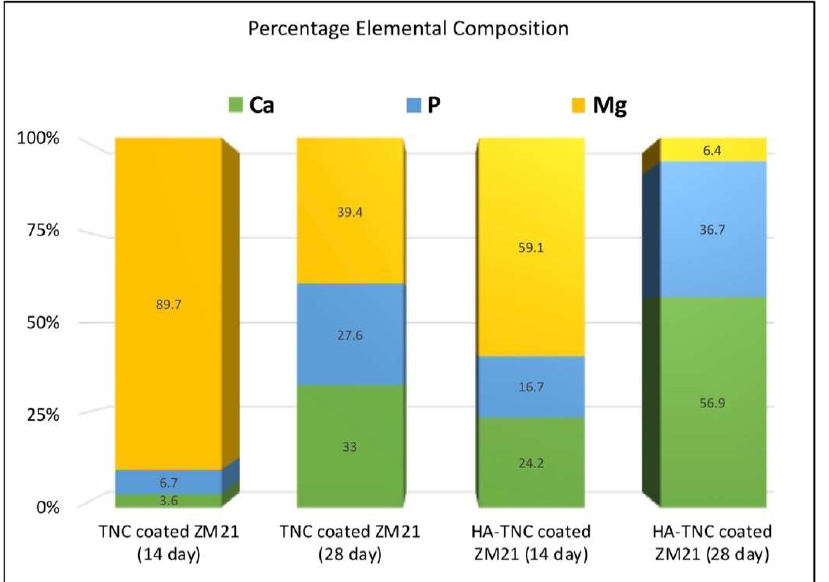
Figure 10. The atomic percentage of Ca, P, and Mg elements in apatite deposited on HA-TNC-coated ZM21, and TNC-coated ZM21 samples after 14 and 28 days of SBF immersion.